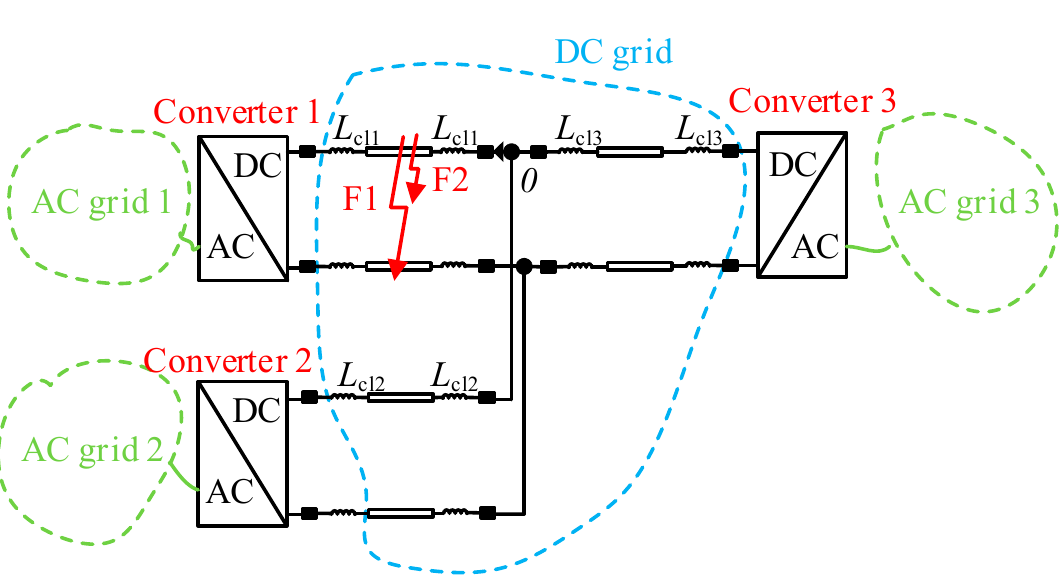
Figure 5. Simulation model of multi-terminal radial AC/DC hybrid distribution network. Table 1. Parameters of the simulation model.